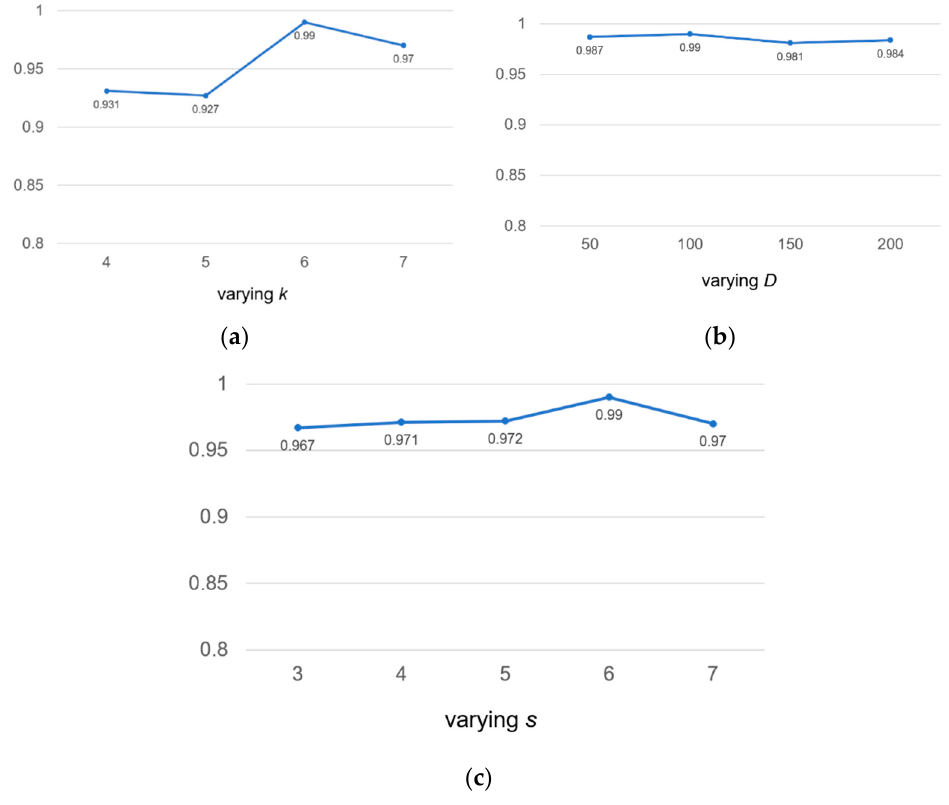
Figure 5. Sensitivity analysis of hyperparameters for k -mer length k , embedding dimension D and the stride s on the human2 dataset. auROC score are displayed.